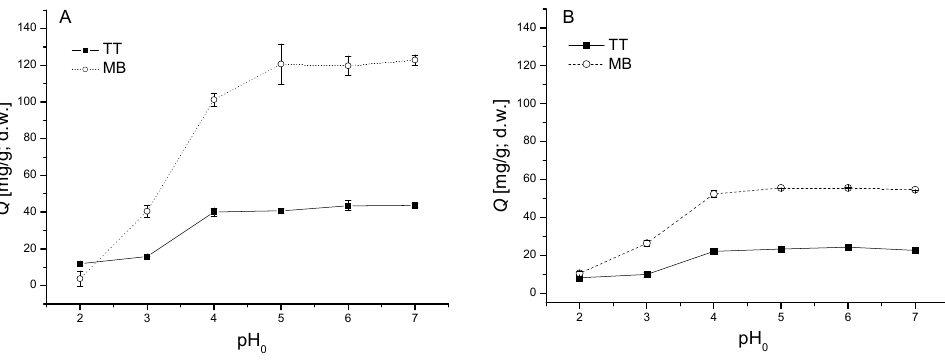
Figure 2. Influence of initial pH 0 on thioflavin T (TT) and methylene blue (MB) biosorption by biomass of moss V. dubyana ( C B = 0.5 g/dm 3 ) from single ( C 0 TT = 40 mg/L or C 0 MB 80 mg/L; A ) and binary ( C 0 TT = 40 mg/L and C 0 MB = 40 mg/L; B ) solutions at 25 °C for 2 h. Error bars represent standard deviation of the mean (±SD, n = 2).